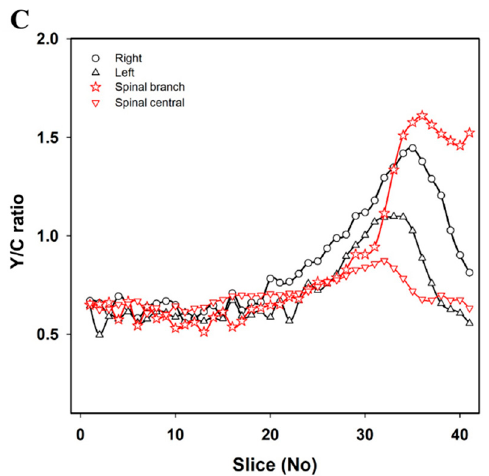
Figure 5. In situ Pb biosensing in the larval CNS of Drosophila using high-resolution two-photon FRET ratio imaging. ( A ), A 3D reconstructed (projection) image of the larval CNS taken using a two-photon FRET ratio microscope (41 sections in total) was rotated by 360 ◦ . ( B ), Twelve representative sections of Y/C ratio images are shown. The color bar in B represents ratio values from 0.1 to 2.5. The scale bars are 100 μ m. ( C ), The emission ratio values of these 3D-sectioned FRET Y/C ratio images are displayed for different depths (slice number) and certain regions were selected, such as the right ( ○ ) and left ( △ ) parts of the larval brain hemisphere and the branch ( ☆ ) and center ( σ ) of the spinal cord.